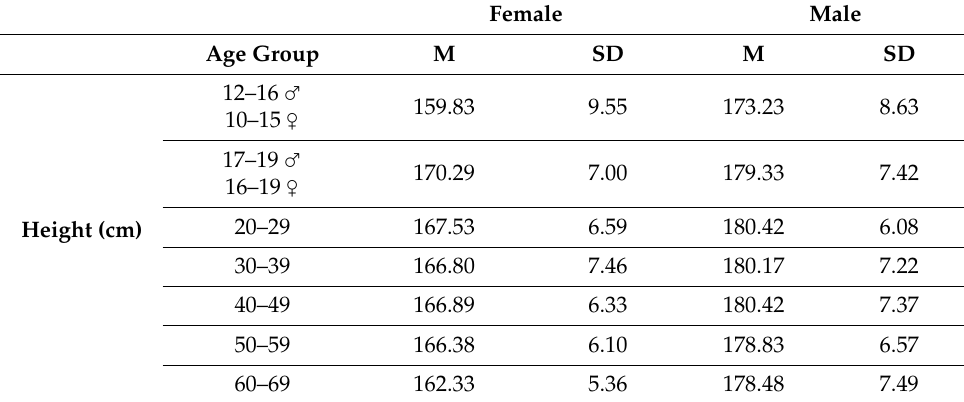
Table 4. Anthropometric data of subjects. BMI, body mass